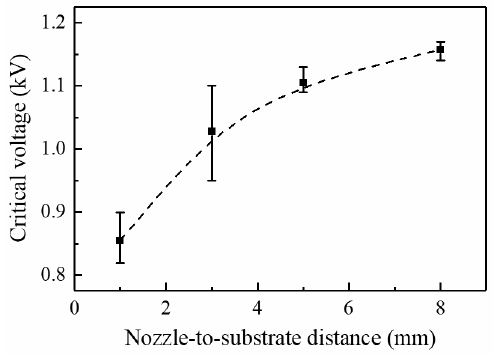
Figure 5. The effect of nozzle-to-substrate distance on critical voltage. The flow rate is 100 μ L/h.